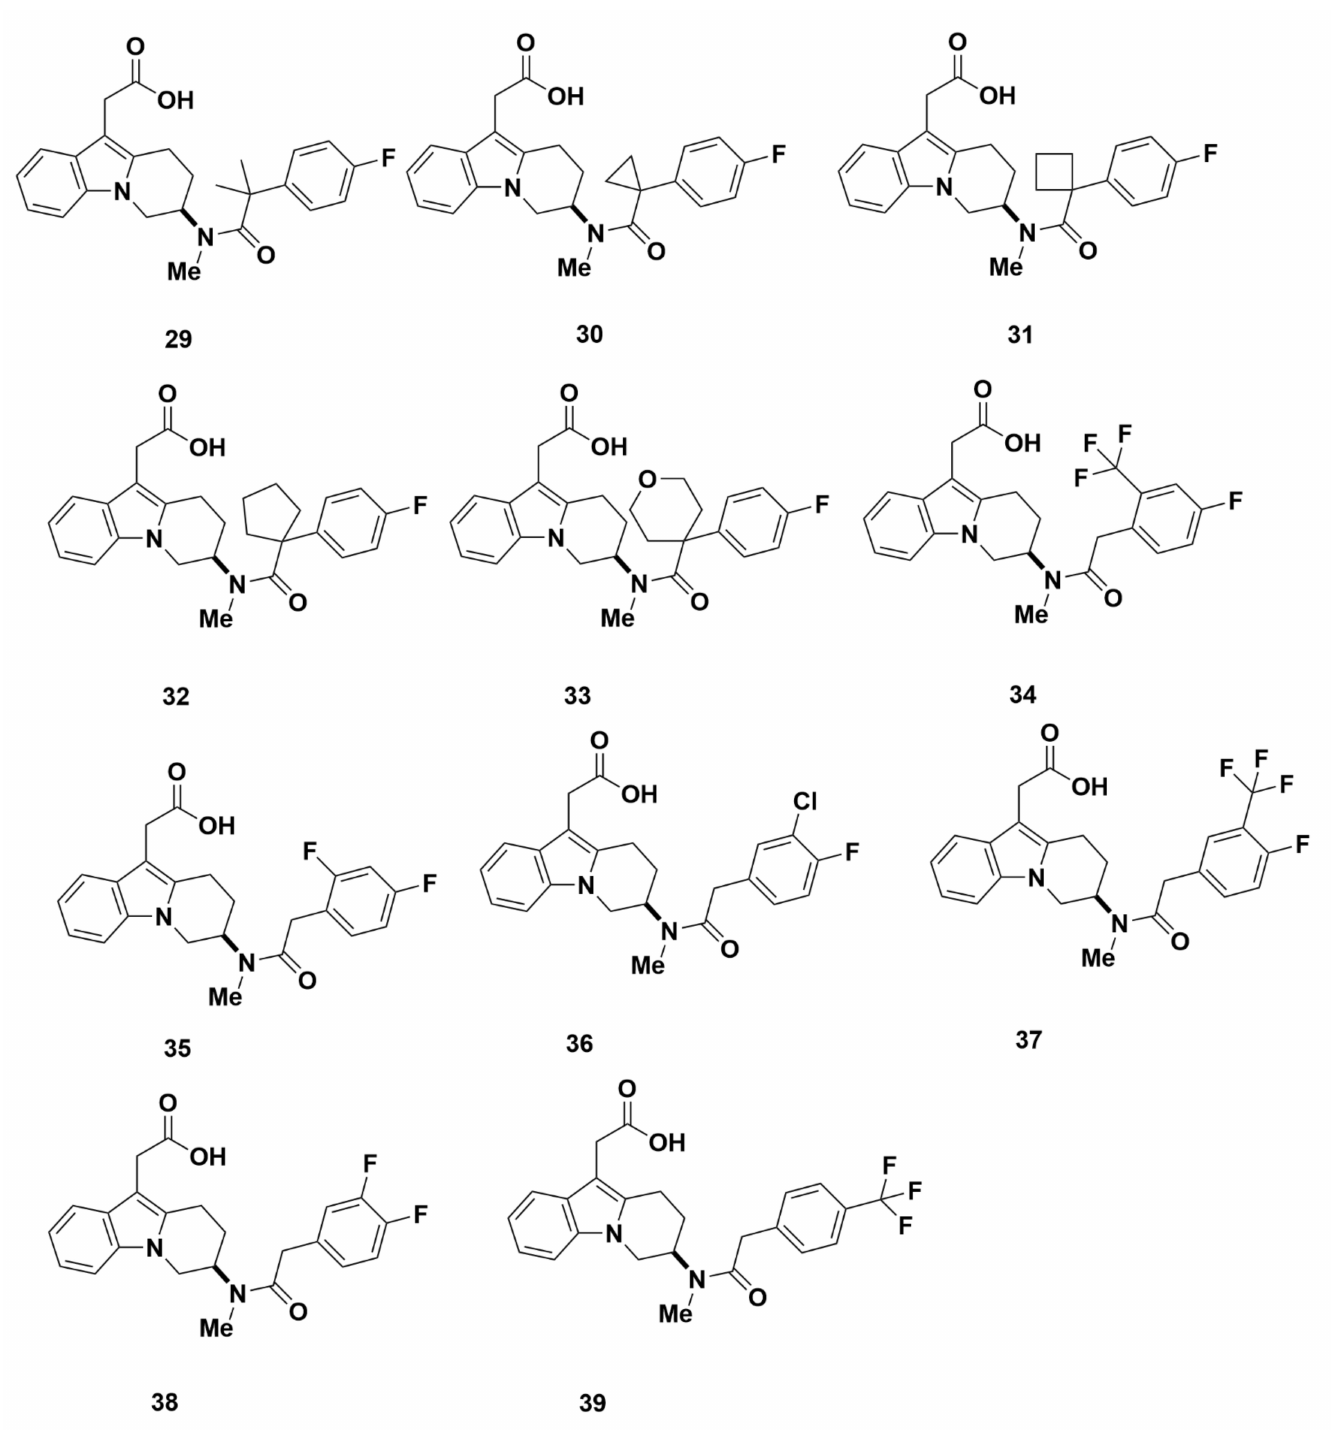
Figure 9. Molecular structures of compounds 29 – 39